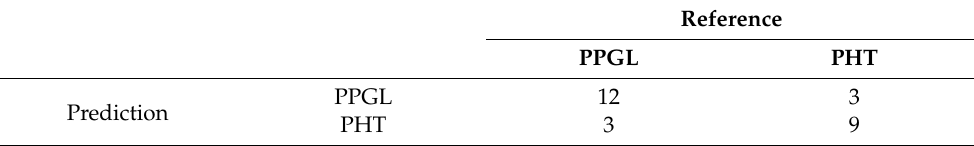
Table A8. Confusion matrix showing the actual and predicted labels for PPGL vs. PHT.